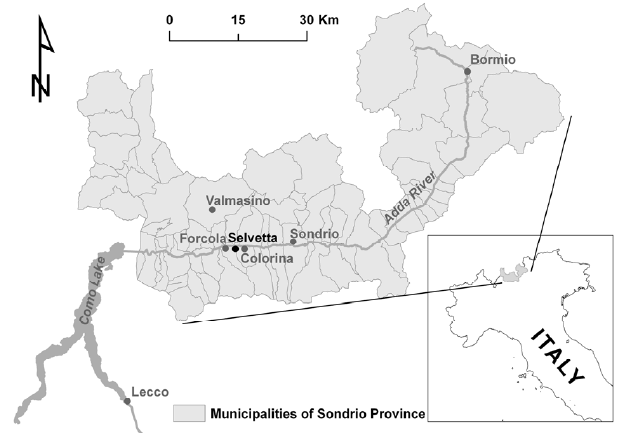
Fig. 1. Location of the Selvetta case study